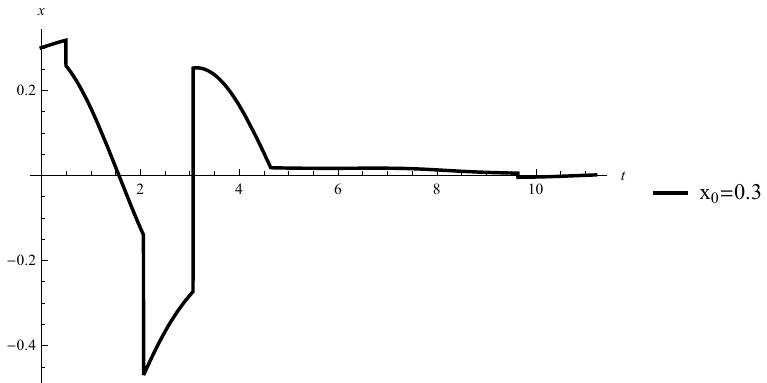
Figure 3: Graph of solution of (44) for one value of each random variable τ k .